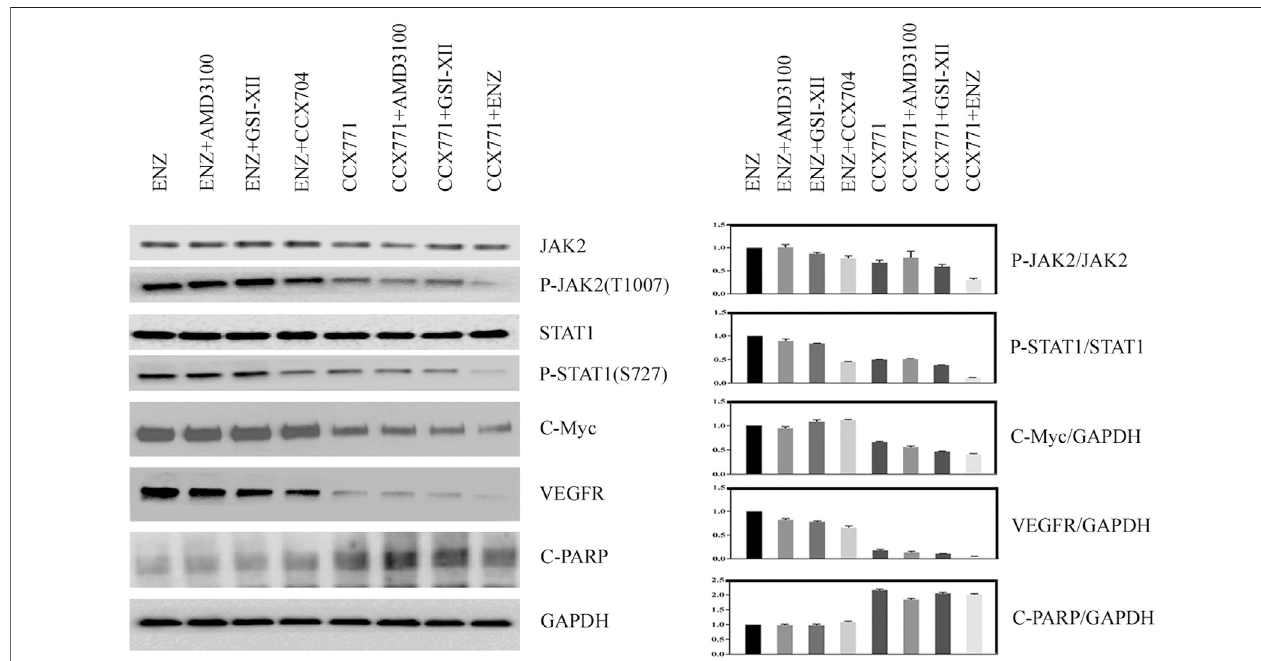
FIGURE 1 | Comparison of CXCR7 downstream signaling proteins between CCX771-based treatment and ENZ-based treatment. (A) Western blotting demonstrated that the expression of phosphorylated JAK2, phosphorylated STAT1, C-Myc, and VEGFR markedly decreased, but the expression of cleaved-PARP-1 increased in CCX771-based treatment cells. The combination treatment of CCX771 + ENZ exhibited much greater synergistic suppression of phosphorylated JAK2, phosphorylated STAT1, C-Myc, and VEGFR. (B) All western blot band densities were quantitatively analyzed.